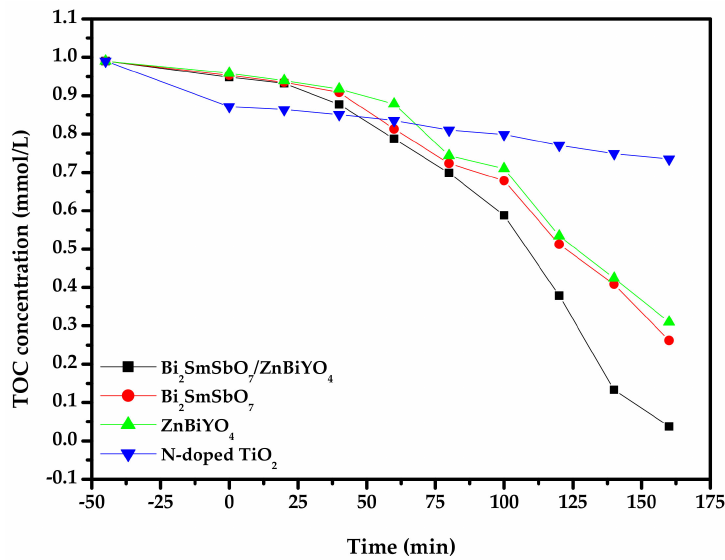
Figure 13. Concentration changing curved line of TOC during PD of DO in dye wastewater with Bi 2 SmSbO 7 /ZnBiYO 4 heterojunction or with Bi 2 SmSbO 7 or with ZnBiYO 4 or with N-doped TiO 2 as catalyst under VLI.